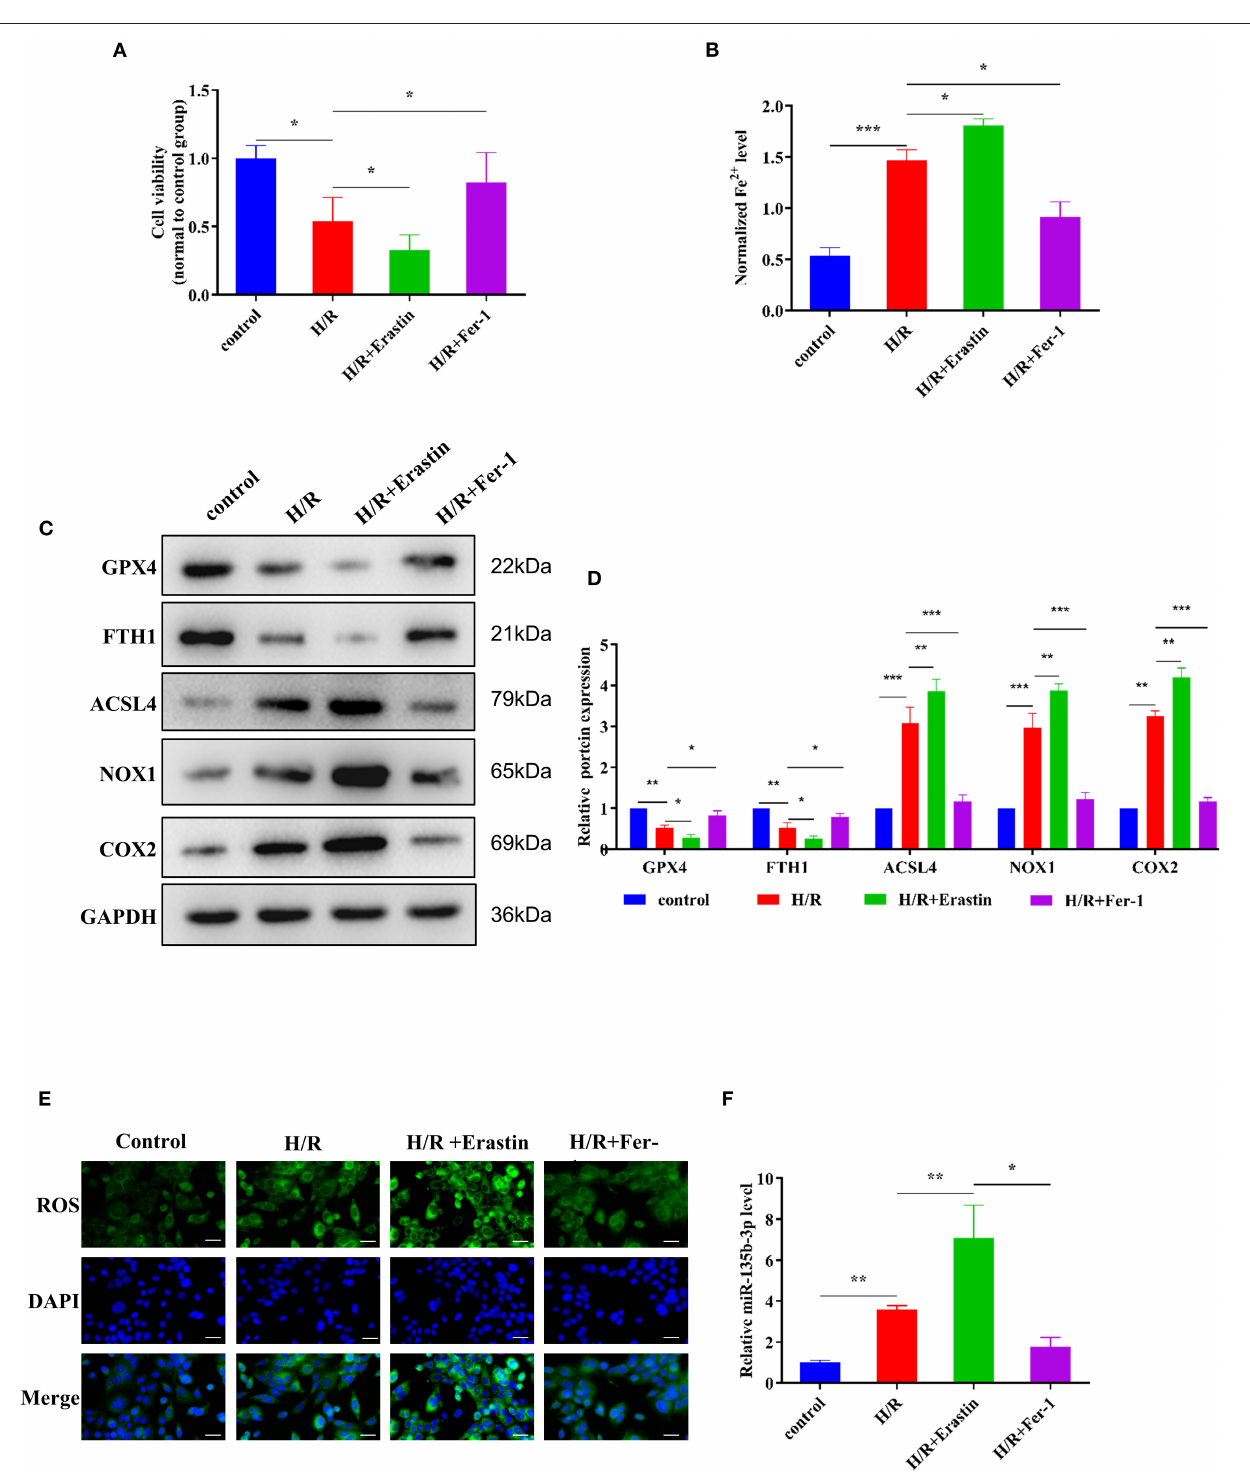
FIGURE 3 | Ferroptosis affects cell survival and miR-135b-3p expression in H9C2 cells after H/R. This part of the study was based on the untreated H9C2 cells and H/R-treated H9C2 cells that were treated with erastin or Fer-1 ( n = 3). (A) MTT assay was conducted to detect the effect of erastin and Fer-1 on the viability of H/R H9C2 cells. (B) The ferrous iron level in H9C2 cells with different treatments was measured by using the iron assay kit. (C) Western blotting was used for detecting GPX4, FTH1, NOX1, ASCL4, and COX2 expression in different H9C2 cells; quantitative analysis is shown in (D) . (E) C11-BODIPY was used to detect the ROS level in H9C2 cells subjected to different treatments. DAPI staining was used for nuclear localization. Scale bar = 50 µ m. (F) RT-qPCR analysis of the expression of miR-135b-3p in H9C2 cells. *** p < 0.001, ** p < 0.01, * p < 0.05. Error bars represent the mean ± SD of triplicate experiments.